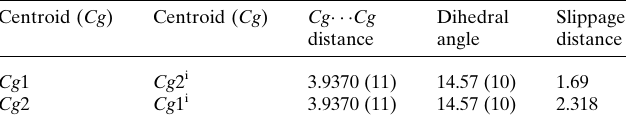
Table 2 (cid:2) – (cid:2) interaction details (A˚ , (cid:3) ). Cg 1 and Cg 2 are the centroids of the C7/N1/C8/N2/O2 and C11–C16 rings, respectively